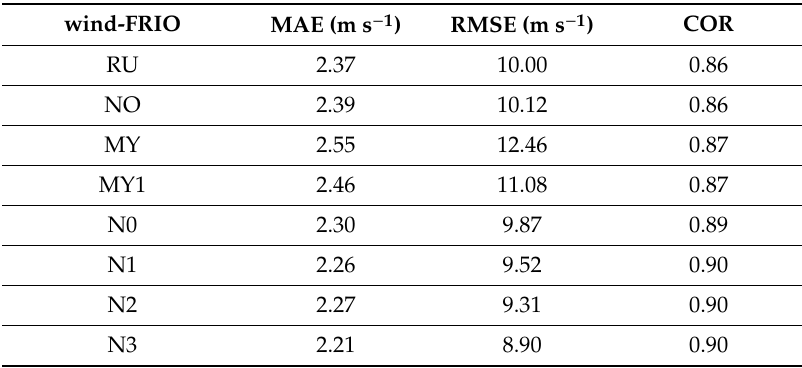
Table A11. Mean absolute error (MAE), root mean square error (RMSE), and correlation coe ffi cient (COR) for surface wind at Frioul (France) station denoted as